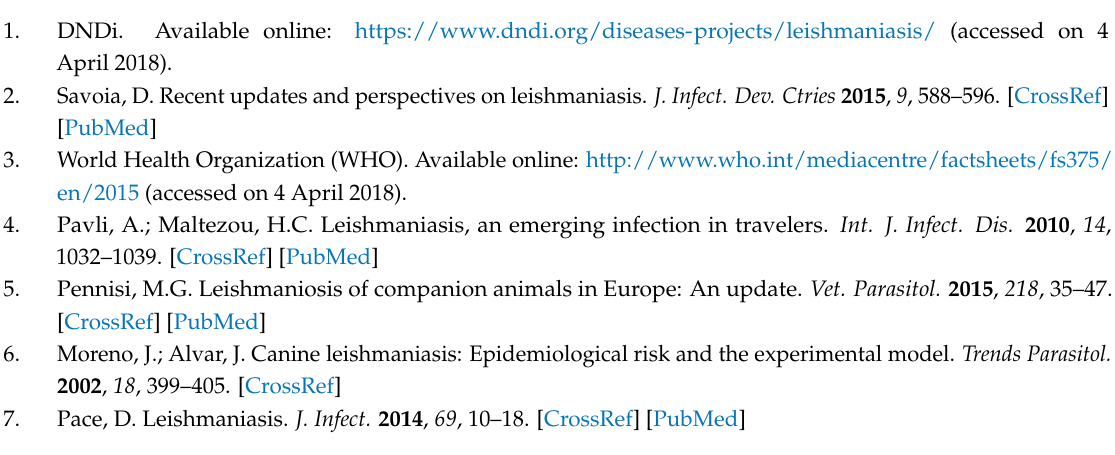
Figure S1: Dose–effect response of L. infantum and L. donovani promastigotes to AmB, PMM and Sb III ; Figure S2A: Isobologram of the interaction of Sb III with DhiS-A at a fixed concentration ratio (1:1); Figure S2B: Isobologram of the interaction of PMM with DhiS-A at a fixed concentration ratio (5:1); Figure S3: Mortality of mouse peritoneal M φ induced by different concentrations of flavonolignans; Table S1: Effect of flavonolignans (120 µ M) on the multiplication of L. donovani and L. infantum